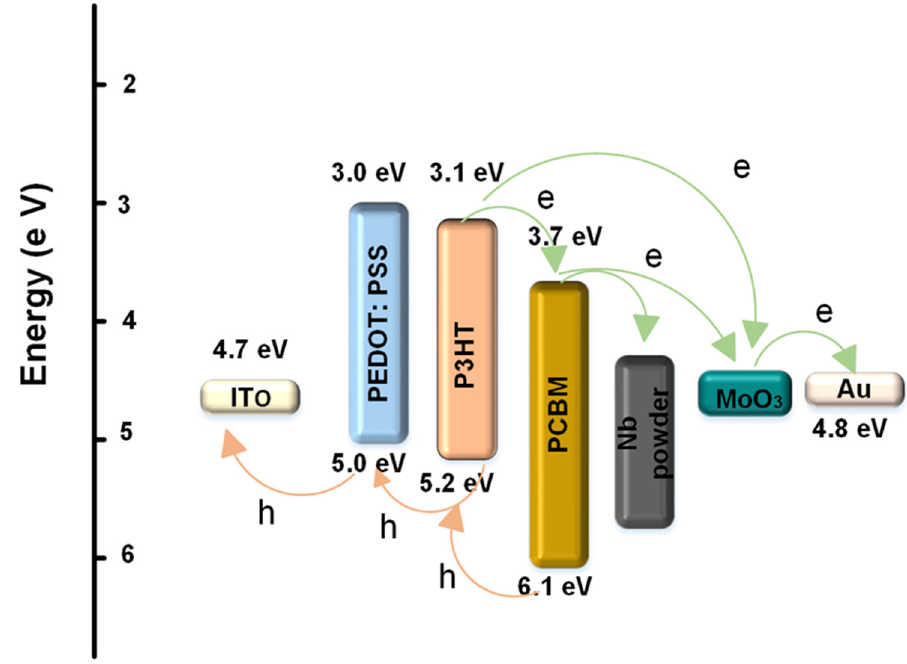
Figure 6. Diagram of energy levels for a P3HT PCBM:Nb bulk heterojunction solar cell with an interface layer.